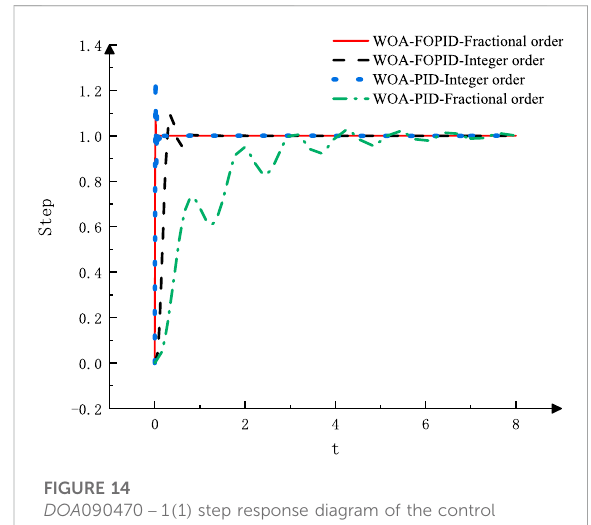
FIGURE 14 DOA 090470 − 1 ( 1 ) step response diagram of the control Figure 19. The control system adopts a modular design, effect of different combination strategiesof thehydraulic and each functional module runs independently without interference, so as to avoid whole equipment paralysis due to a single failure. The electric control system can be divided into fi ve modules: main circuit unit, power unit, protection unit, signal conditioning isolation unit, and logic control unit. The block diagram of the control system module is shown in Figure 20. TABLE 5 Comparison of different combination strategies and control indexes of the DOA 090470 − 1 ( 1 ) hydraulic cylinder. Combination Dynamic indicators Standard deviation Overshoot (%)